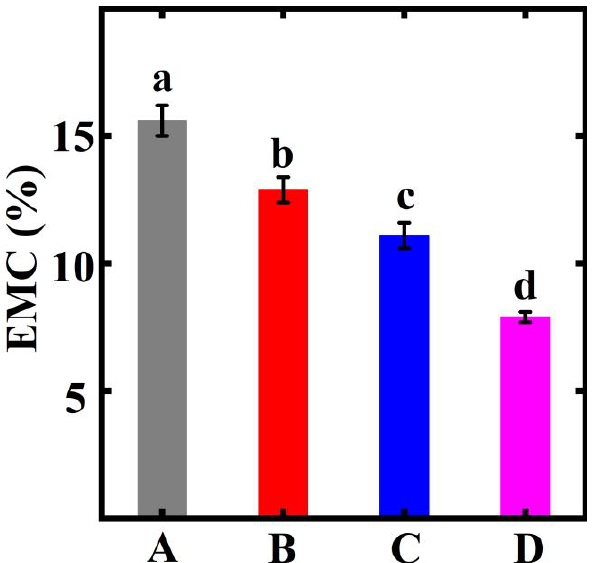
Figure 5. Physical property (EMC) of the moso bamboo. Different significant difference between different groups ( p < 0.05). The error bar in the picture represents the standard deviation.